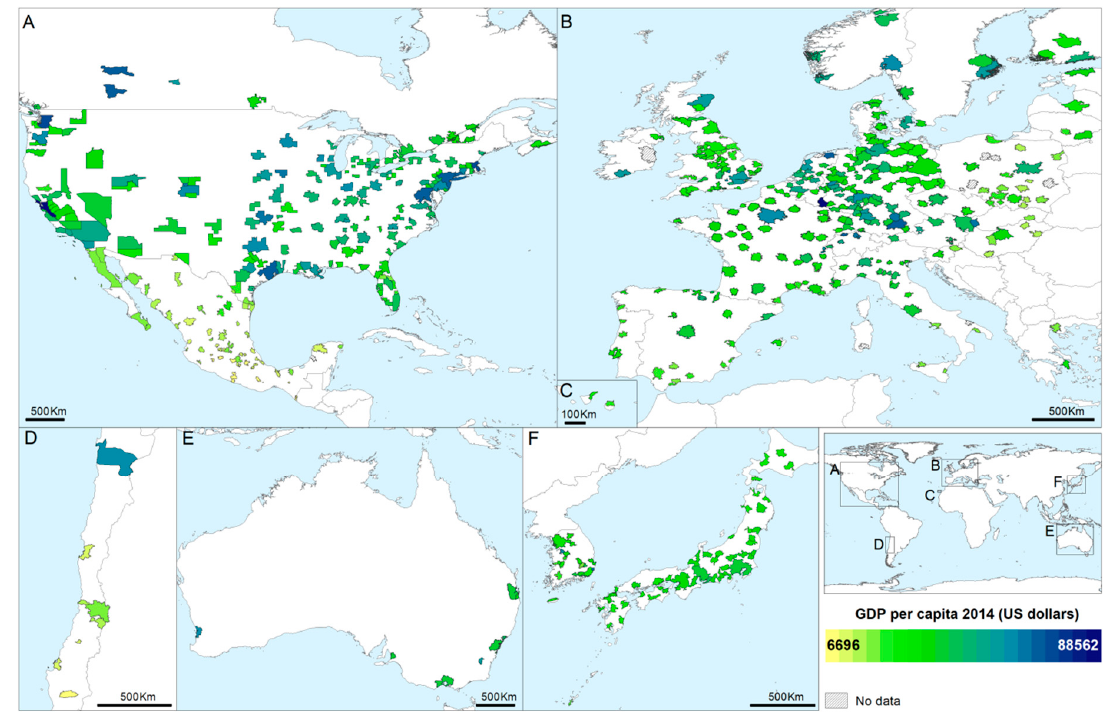
Figure 2. Example of the gross domestic product per capita (GDP) in USD for the year 2014 combined with the FUA boundaries in 32 OECD countries: ( A ) Canada, the USA and Mexico; ( B ) and ( C ) European countries; ( D ) Chile; ( E ) Australia; ( F ) South Korea and Japan. “ No data ” FUAs are included in the OECD metropolitan area dataset but do not have a GDP value for the year 2014. The complete list of FUAs and GDP per capita values can be found in Table S1.